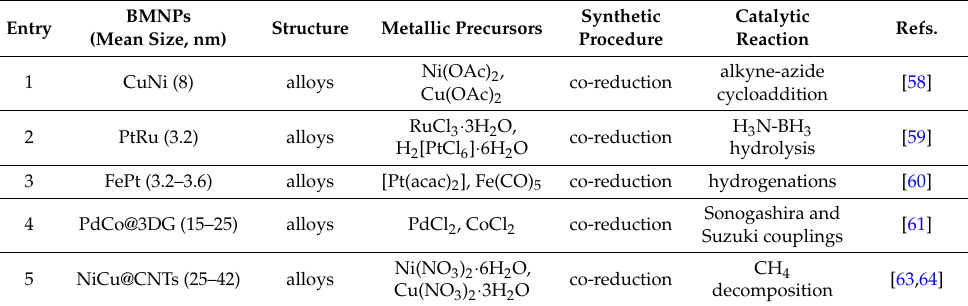
Table 2. Bimetallic nanoparticles in alcohols applied in catalysis.